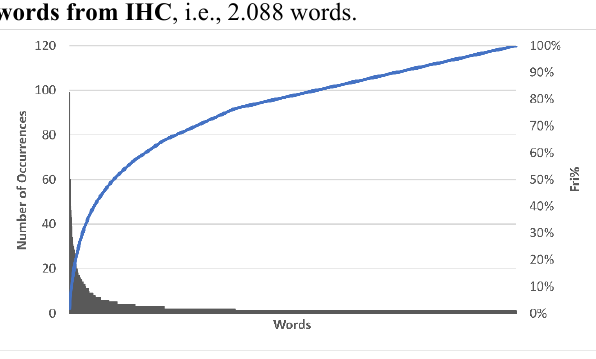
Figure 7. Histogram of the N4 (2.088) words from